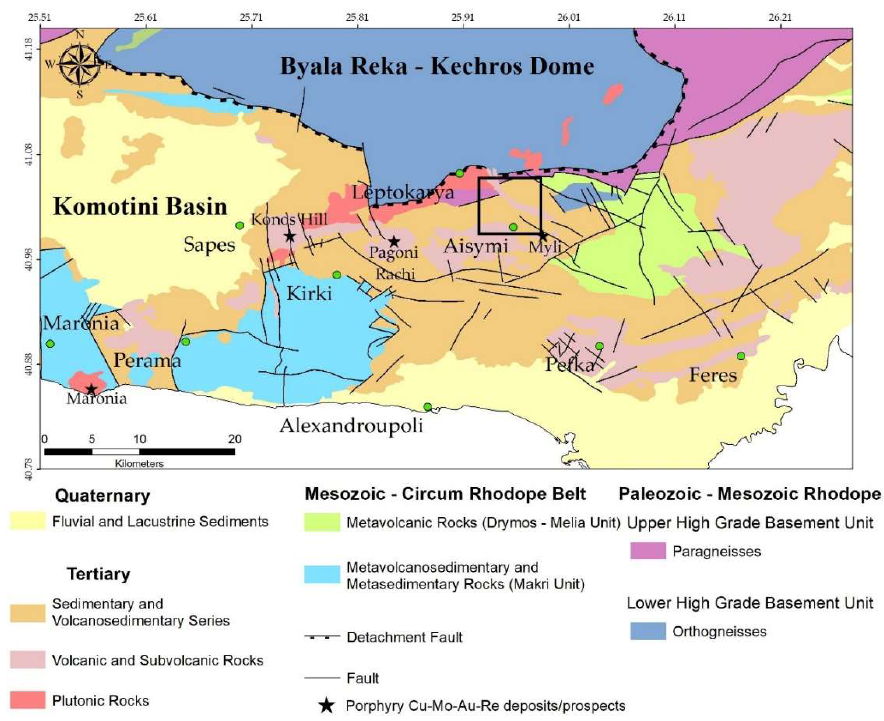
Figure 1. Simplified geological map of the south-eastern Rhodope (modified after [11] and [18]). Black square marks the study area.